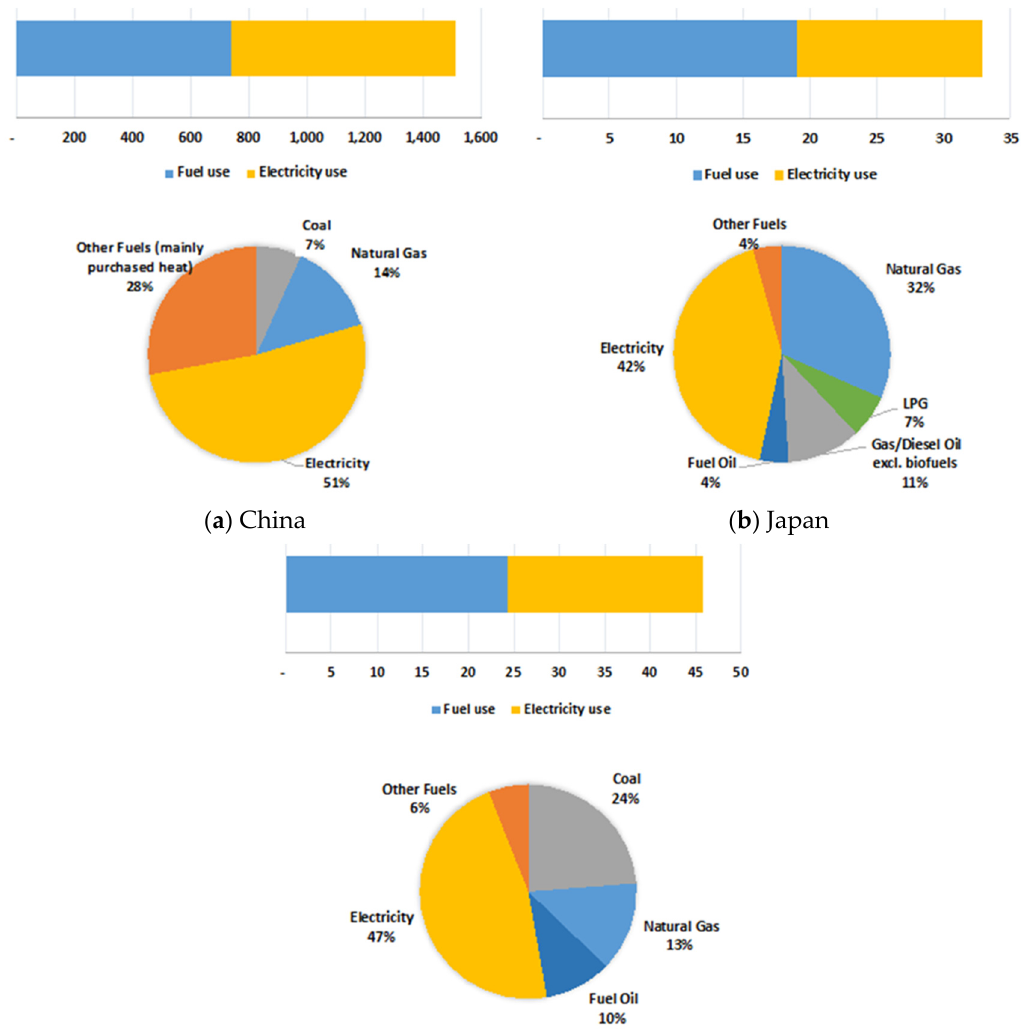
Figure 2. Fuel and electricity used in the textile industry in China, Japan, and Taiwan in 2019 (absolute values are in PJ) (Data source: [16]).